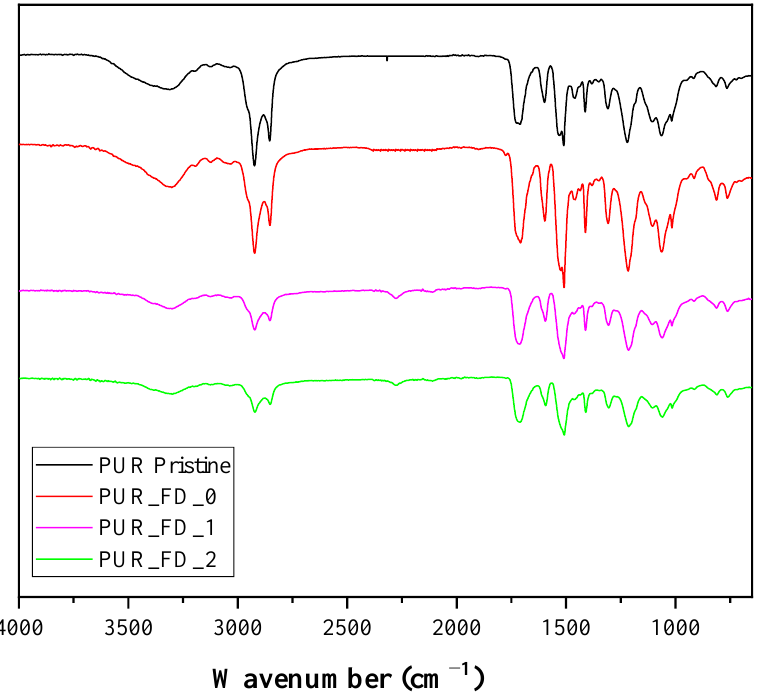
Figure 5. FTIR spectra of the composite PUR foams in the range of 3000–800 cm − 1 wavenumber. SEM micrographs of the foam cross sections are shown in Figure 6. For the case of solvent exchange route, it was decided to report PUR_SE_2 morphology to validate the occurring of shrinking and collapse of the produced foam. For the best examined cases (foams reinforced with FD_CNCs), cell size distribution was hence evaluated through image analysis and displayed in the lower part of Figure 6. This latter is a crucial factor dictating specific properties such as compressive strength or insulating capabilities of the obtained foams. PUR pristine showed, as expected, a closed cell structure (typical of the rigid foams) [59] with a cell size ranging around 400 μ m. For the cases of PUR_FD_0, PUR_FD_1 and PUR_FD_2, the addition of SF_CNCs induced a reduction of the average cell size, (around 100 μ m for PUR_FD_1 and PUR_FD_2), with respect to the unfilled foam, where closed cell structure was preserved [6,9]. For the case of PUR_FD_0, it was possible to observe CNC aggregation (depicted in yellow circle in Figure 6), proving that CNCs were not appropriately dispersed with the polymer matrix. Similar results were observed also in the previous literature [17,60 – 62], where CNCs were selected as reactive fillers in rigid polyurethane foams leading to more closed cell structures with respect to the non-reinforced foam. On the other hand, the effect of the filler functionalization seemed to be beneficial for CNC dispersion within the polyurethane matrix, as no cospicous agglomeration of CNCs was noticeable. In details, the intercalation of FD_CNC1 led to lower average cell size with respect to the case of PUR_FD_2, although showing similar size distribution. In this regard, it might be possible that the higher amount of the grafted bio-polyol along with greater OH number of the NX9203 polyol, used to graft FD_CNC1, played a key role in affecting filler dispersions and the final PUR foams characteristics. These results were in agreement with the previous literature [1], where polyol- grafting CNCs were opportunely dispersed in a bio-based polyurethane matrix, leading to cell size reduction and improved interconnection within cellular structure, compared